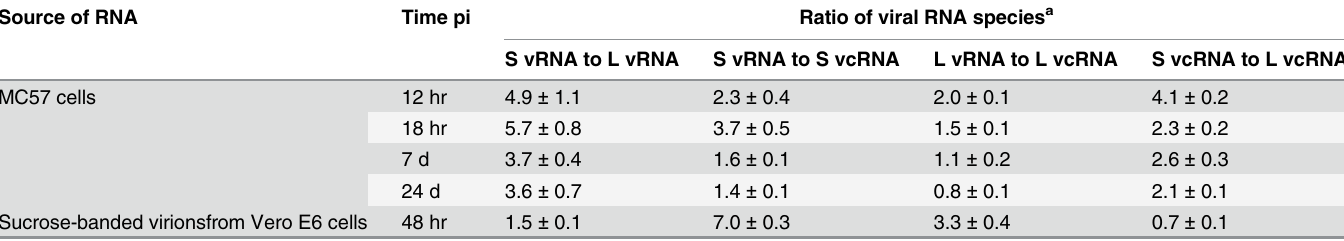
Table 5. Ratio of viral RNA species found in virions and infected cells.